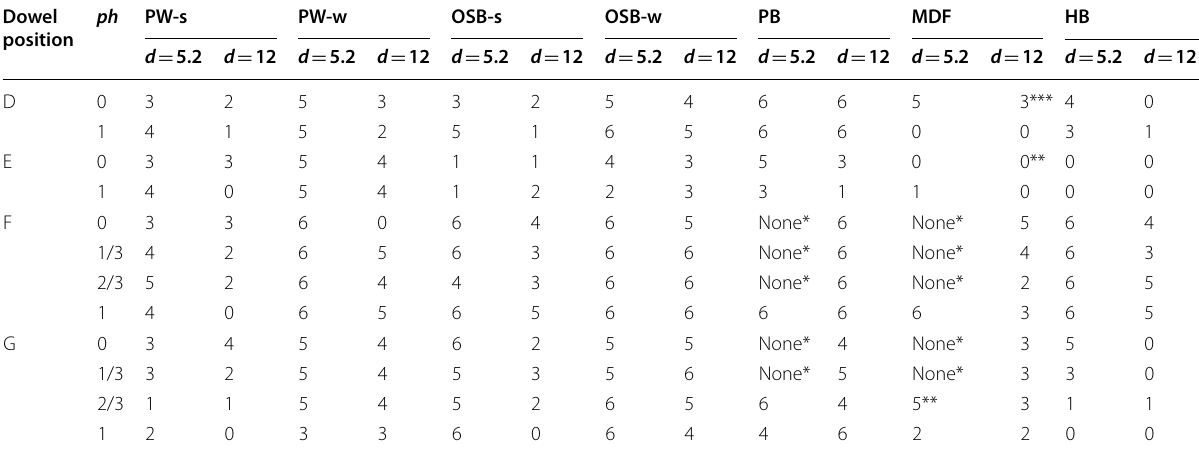
* All specimens were fractured during nailing. **One specimen out of six was fractured during nailing. ***Two specimens out of six were fractured during nailing d and ph mean the dowel diameter and the pilot hole size, respectively